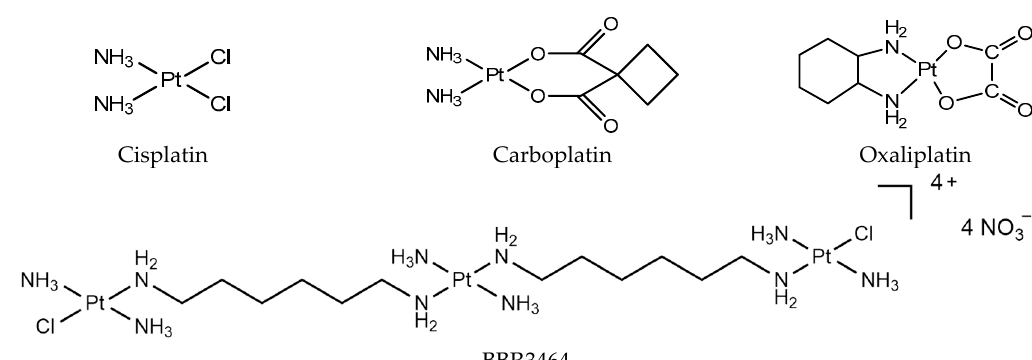
Figure 1. Platinum chemotherapeutic drugs: cisplatin, carboplatin, oxaliplatin, and BBR3464.